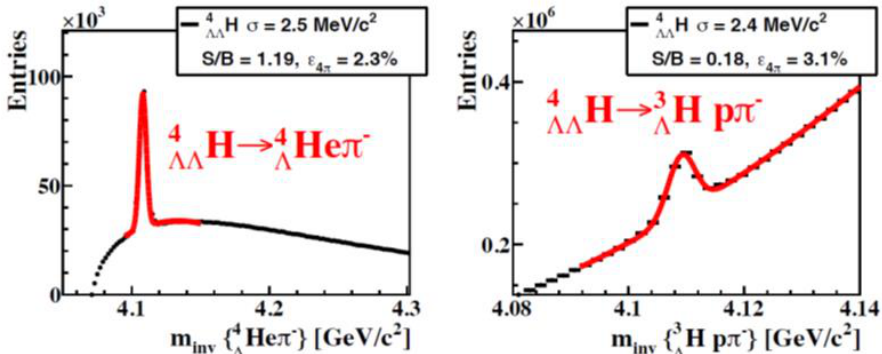
Figure 8. The double-lambda 4 ΛΛ H hypernucleus identified via the reconstructed invariant mass spectra of 4 Λ He π − ( a ) and 3 Λ He p π − ( b ) in 10 12 central Au + Au collisions at 10A GeV. The red lines indicate the signal plus background fit by a polynomial plus Gaussian function